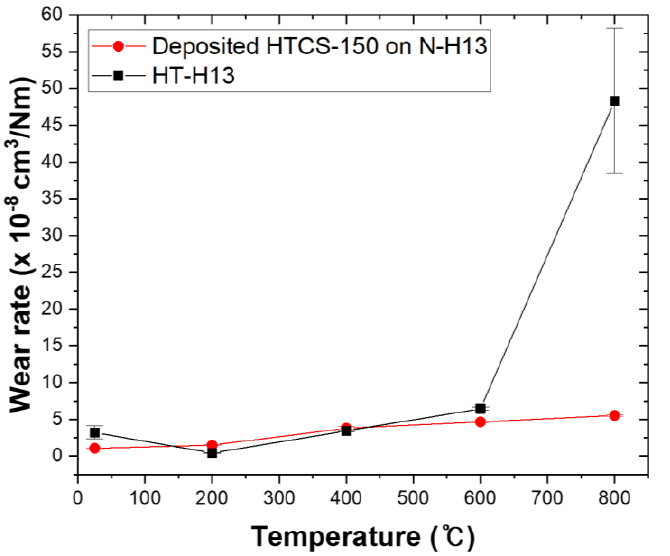
Figure 10. Wear rate of the HT-H13 and the HTCS-150 deposited on N-H13 at elevated temperatures.